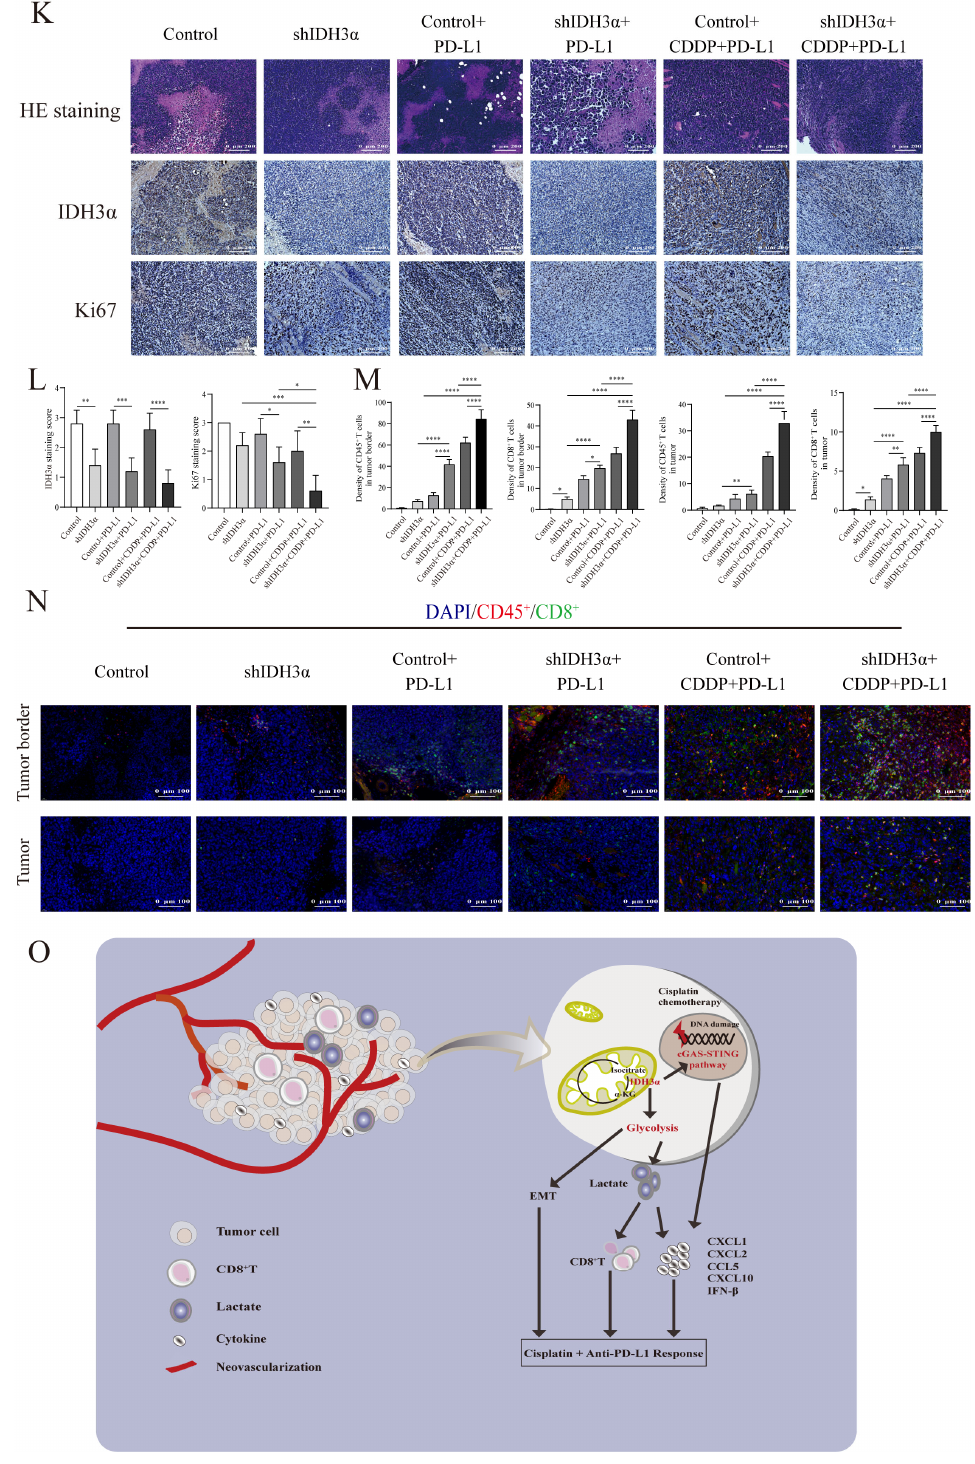
Figure 7. The depletion of IDH3 α sensitized tumors to cisplatin + anti ‐ PD ‐ L1 chemoimmunotherapy and activated the cGAS–STING pathway. ( A ) Analysis of correlation between IDH3 α and immune score for lung cancer (upper) and UCC (lower). Dots represent patients. ( B ) Analysis of the effect of IDH3 α on the infiltration proportion of various immune cells for lung cancer (upper) and UCC (lower). ( C ) The WB detection of cGAS–STING pathway ‐ related protein expression after 20 μ M C ‐ 176 treatment for 24 h. ( D ) qPCR analysis of mRNA expression levels of CXCL1, CXCL2, CCL5, CXCL10, and IFN ‐β after 20 μ M C ‐ 176 treatment for 24 h. ( E ) Experimental design to investigate the role of IDH3 α in anti ‐ PD ‐ L1 and/or cisplatin treatment. U14 cells were transfected with lentivirus and injected into the inguinal region of C57BL/6 wild ‐ type mice (5 × 10 6 cells per mouse). Cisplatin